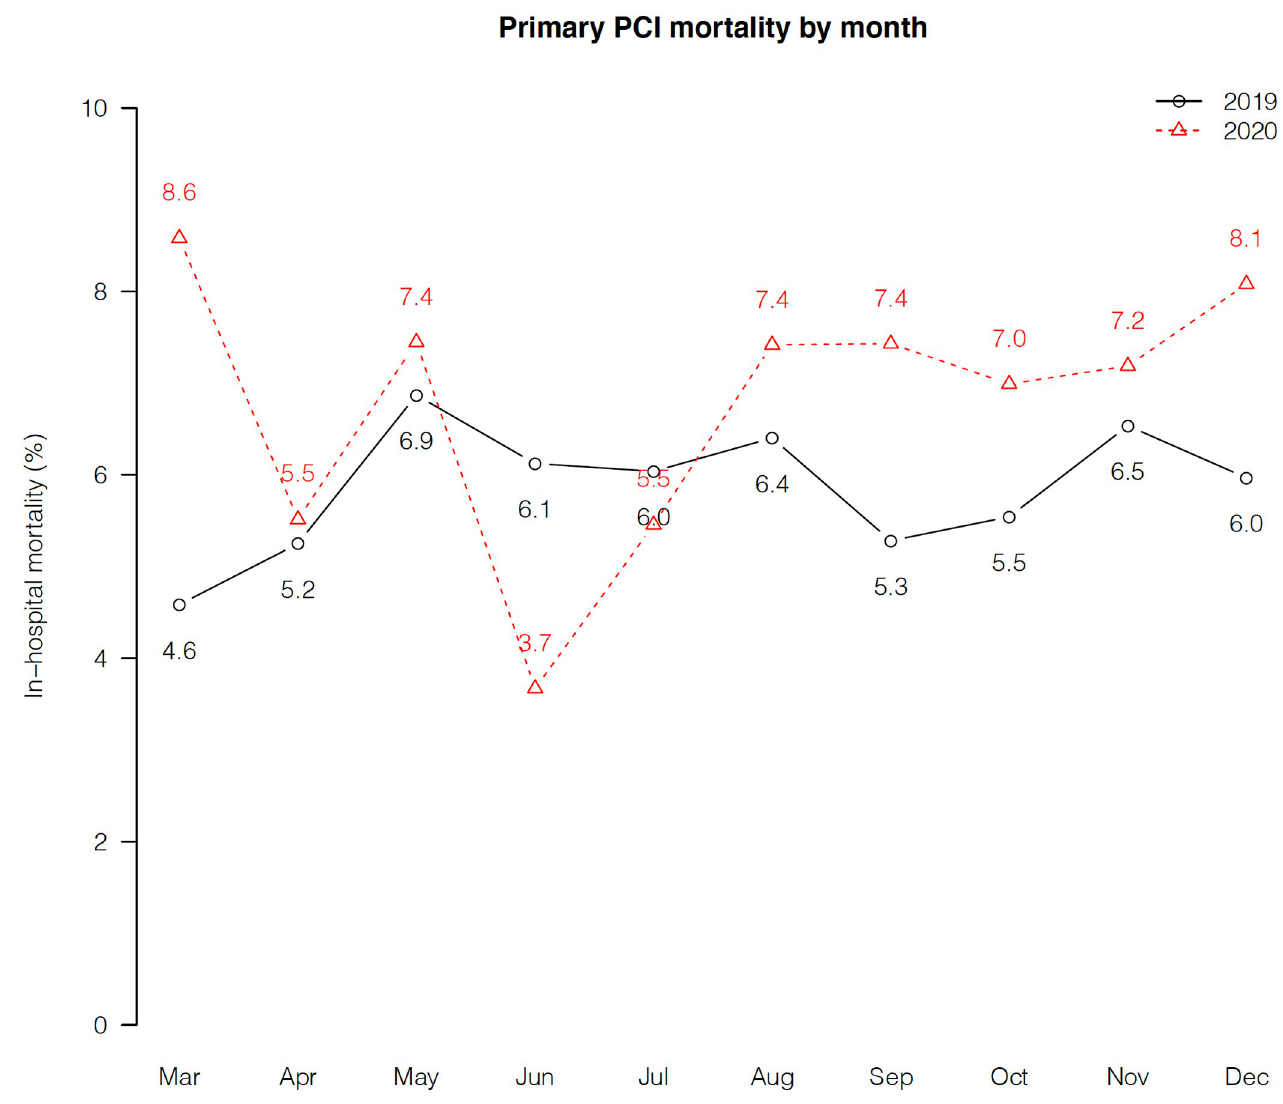
Fig 3. Primary PCI in-hospital mortality by month in the pre-pandemic (black) vs. pandemic (red) period.